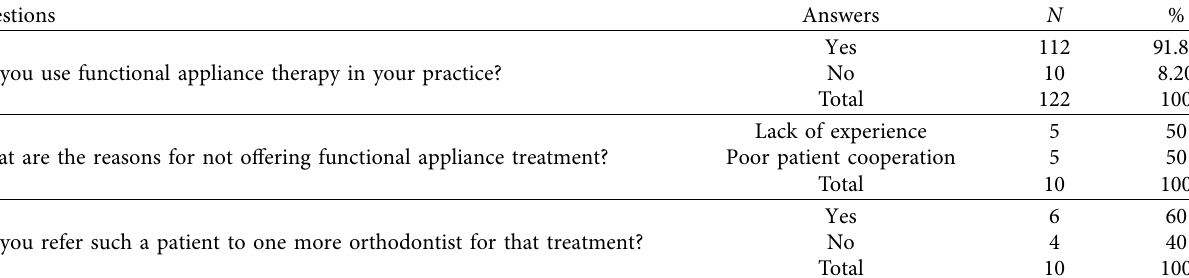
Table 2: Response of participants’ usage of the functional appliances.